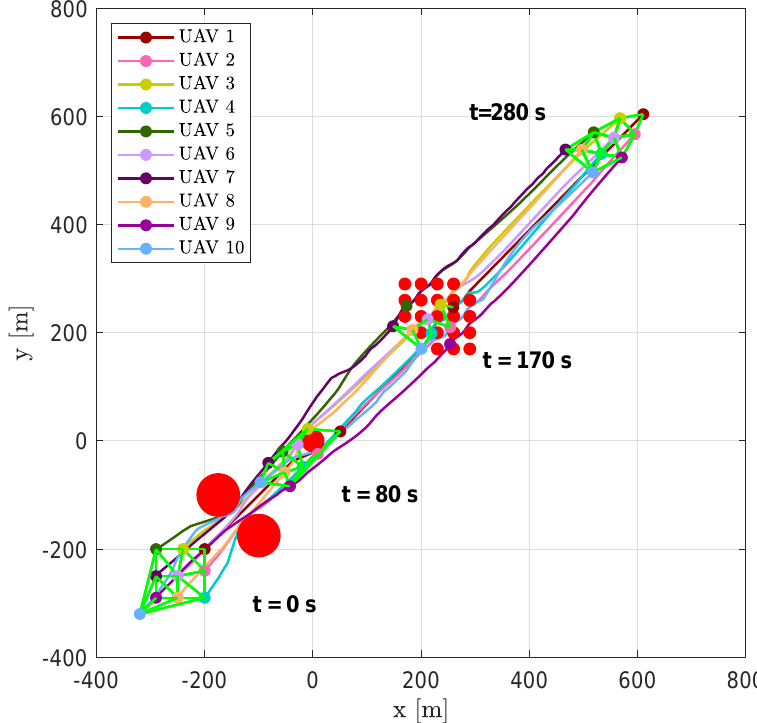
Figure 25. Scenario #3—10 aircraft: UAV trajectories. Red circles represent obstacles; colored markers indicate the UAVs positions at different time instants; green straight lines highlight DTG